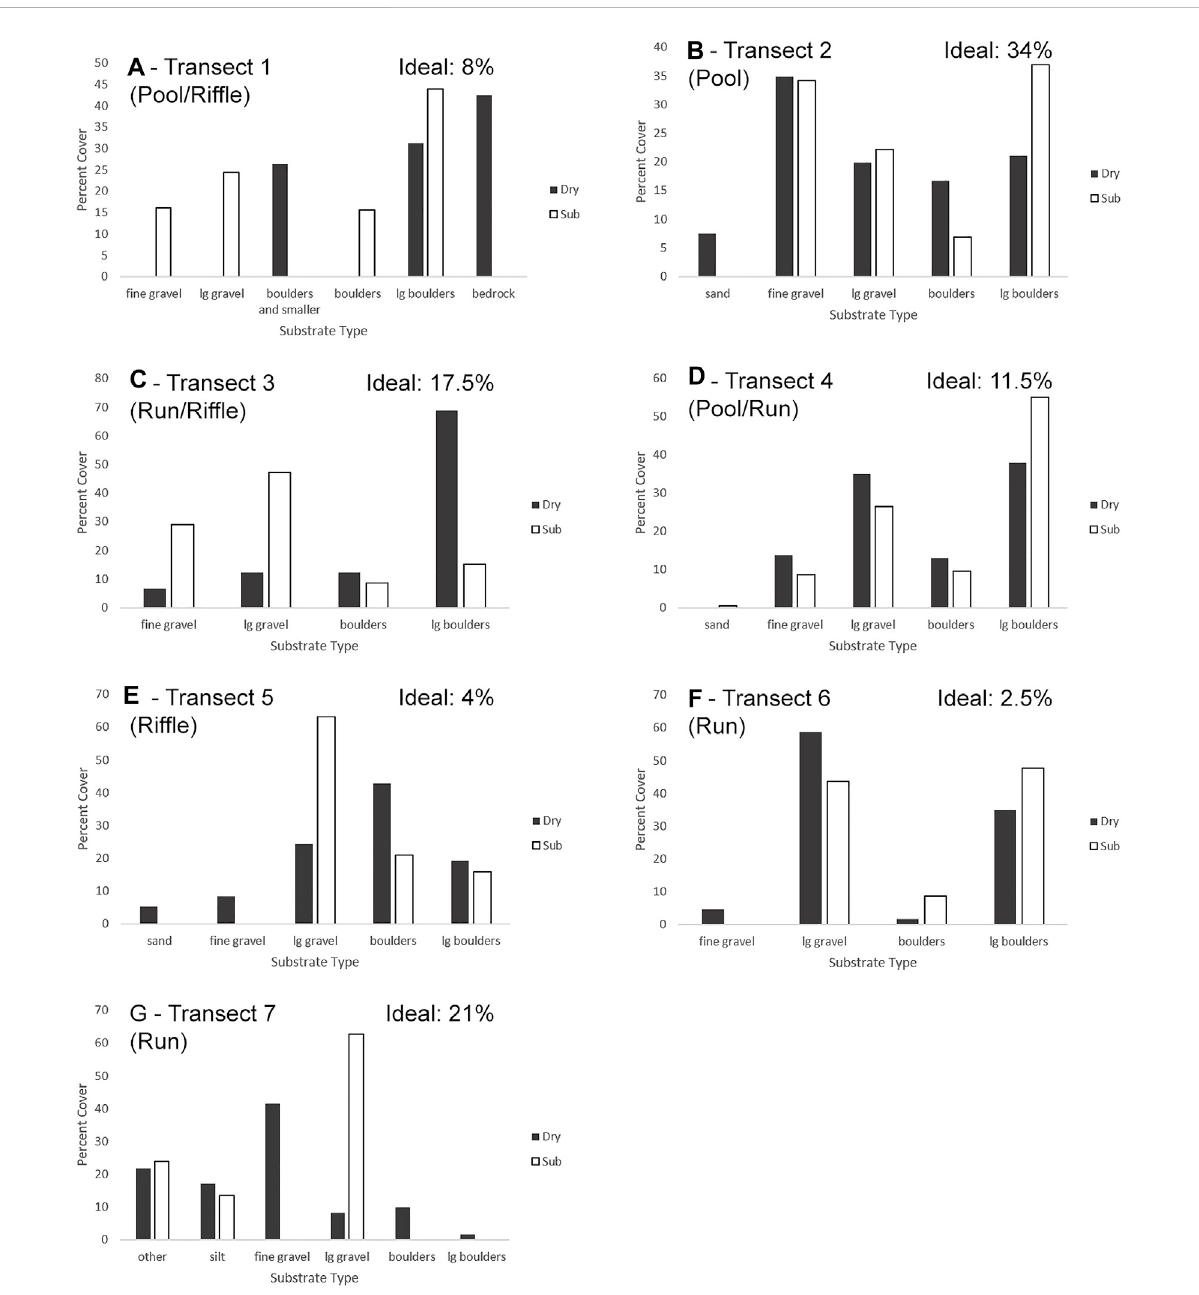
FIGURE 8 Object-based image analysis results for transects 1 – 7 (A – G) on both submerged and dry portions of the river, presented in percent coverage, alongwiththepercentofidealsubstrateoneachtransect.Dryandsubmergedareprocessedseparatelyand%arecalculatedbasedonindividual(dry or submerged) segments but presented together for comparison. Ideal substrate is the total amount of fi ne gravel found in the combined dry and submerged portions of the